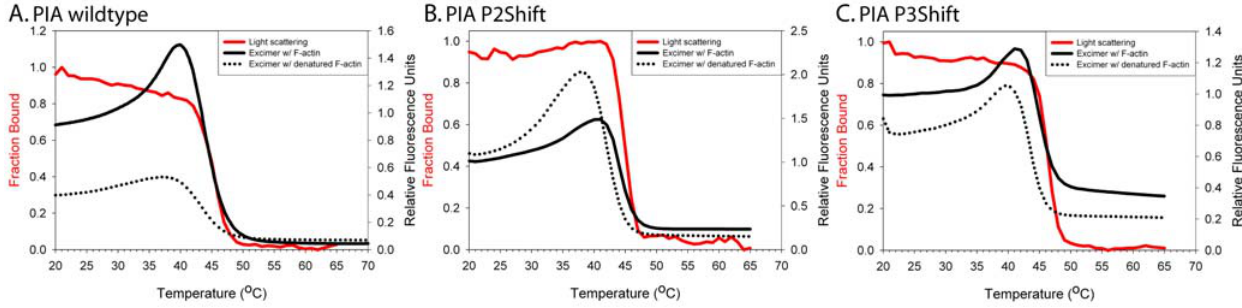
Figure 4. Excimer fluorescence of PIA-labeled (at Cys190) and light scattering of unlabeled wildtype, P2Shift, and P3Shift mutants. A. PIA wt; B. PIA P2Shift; C. PIA P3Shift. Excimer fluorescence and light scattering experiments: Tropomyosin (6 m M) and TnT 70–170 (9 m M) were mixed with phalloidin (27 m M) stabilized F-actin (18 m M). Light scattering (red solid line and left axis with red label) was conducted with unlabeled tropomyosin due to interference from excimer peak in light scattering experiments with labeled tropomyosin. Excimer fluorescence (right axis) in the presence of actin (black solid line) and absence of actin (black dotted lines). Buffer conditions for all of the experiments: 100 mM NaCl, 10 mM sodium phosphate pH 7.5, 2 mM MgCl 2 , 1 mM DTT. Experimental Procedure: The excimer temperature scans were repeated three times at a 1 u C/min scan rate [24]. First, the sample was heated from 0–70 u C and then cooled again. Second, the sample was heated to 90 u C to denature the F-actin and subsequently cooled. In the third scan, post F-actin denaturation, the sample was heated to 70 u C and the excimer peak is detected in the absence of